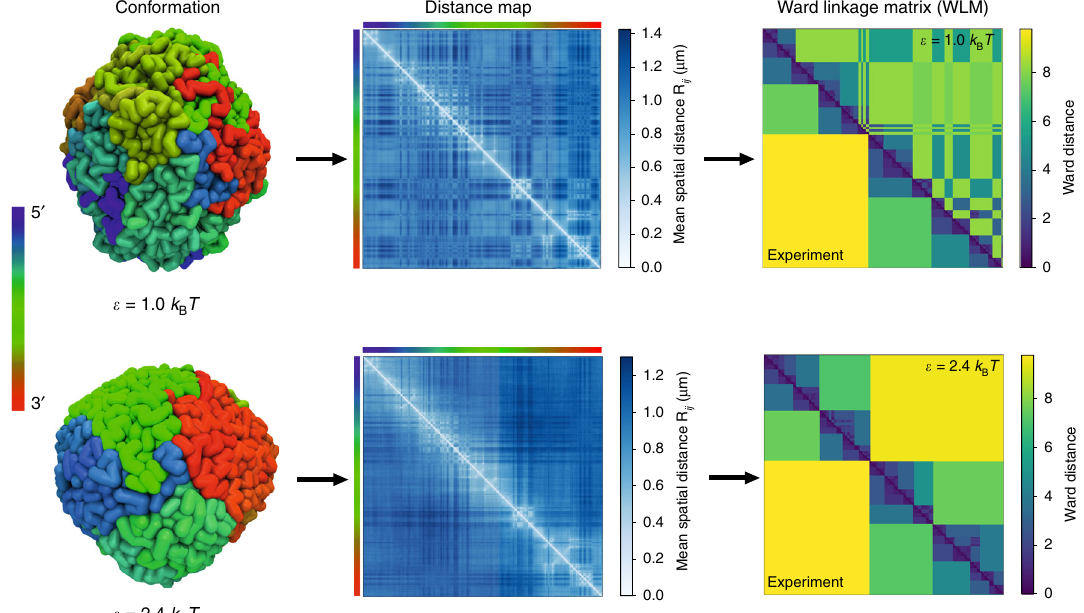
Fig. 4 Chromosome structure in terms of ward linkage matrix (WLM). (Left) Typical conformations of the organized chromosome for ϵ = 1.0 k B T (upper) and 2.4 k B T (bottom). The coloring corresponds to genomic distance from one endpoint, ranging from red to green to blue. (Middle) The ensemble averaged distance maps. (Right) Comparison between the simulated WLMs (upper triangle) and the experiment WLM (lower triangle) inferred from Hi-C contact map. Ward distance is de fi ned in the Supplementary Note